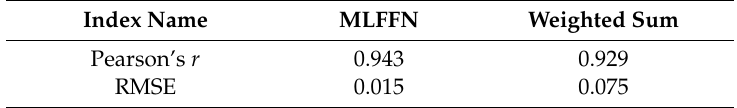
Table 10. The comparison of precision for our MLFFN and weighted sum